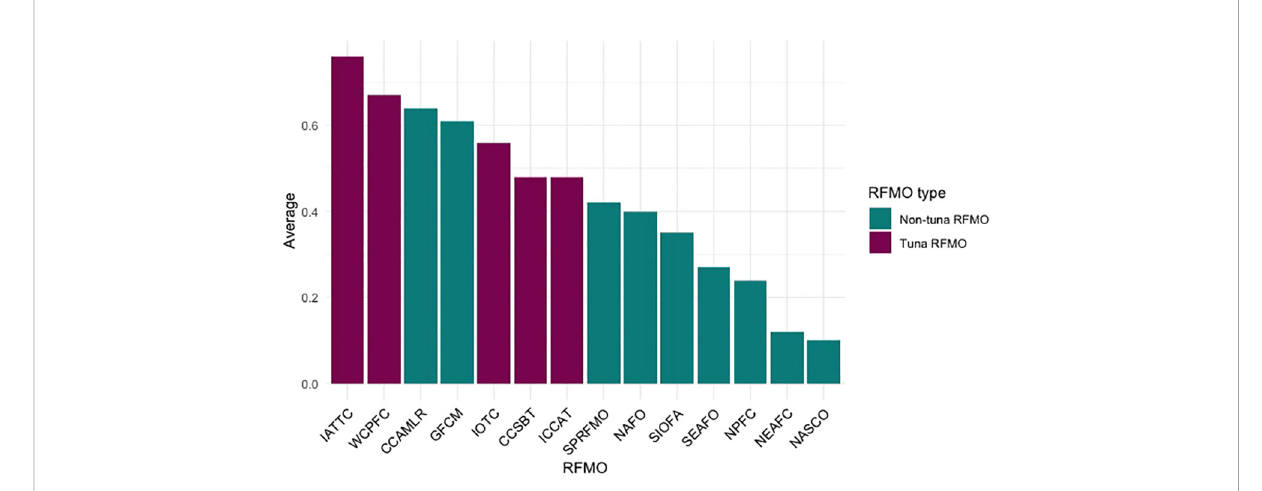
FIGURE 2 Average score for each